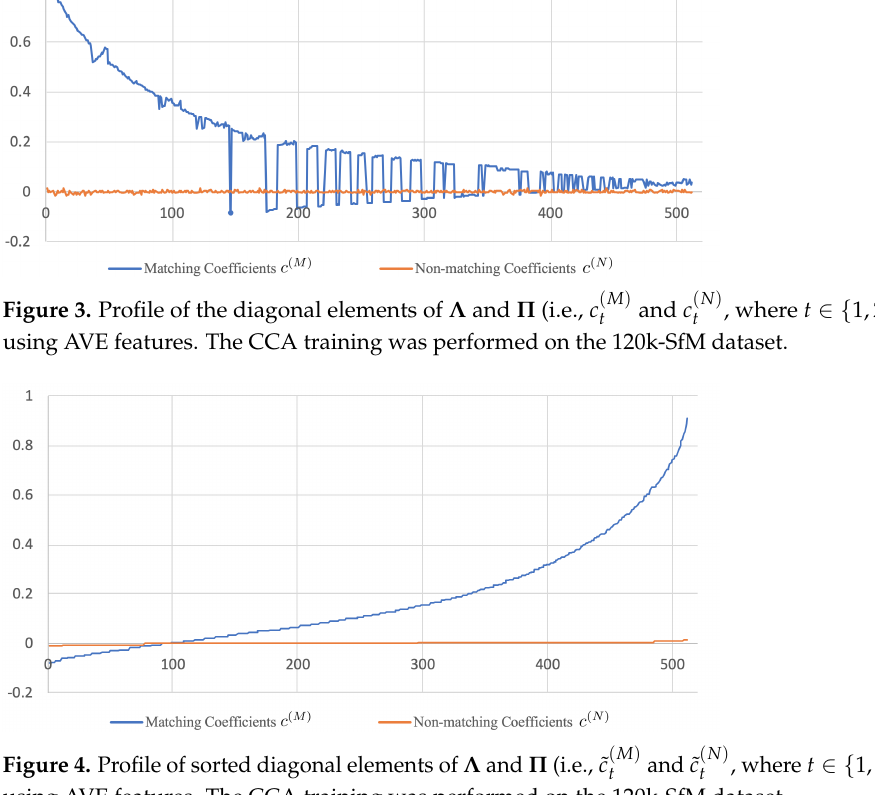
Figure 4. Profile of sorted diagonal elements of Λ and Π (i.e., ˜ c using AVE features. The CCA training was performed on the 120k-SfM